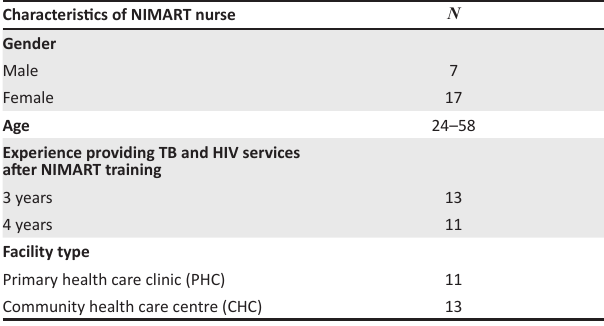
TABLE 1: Participant